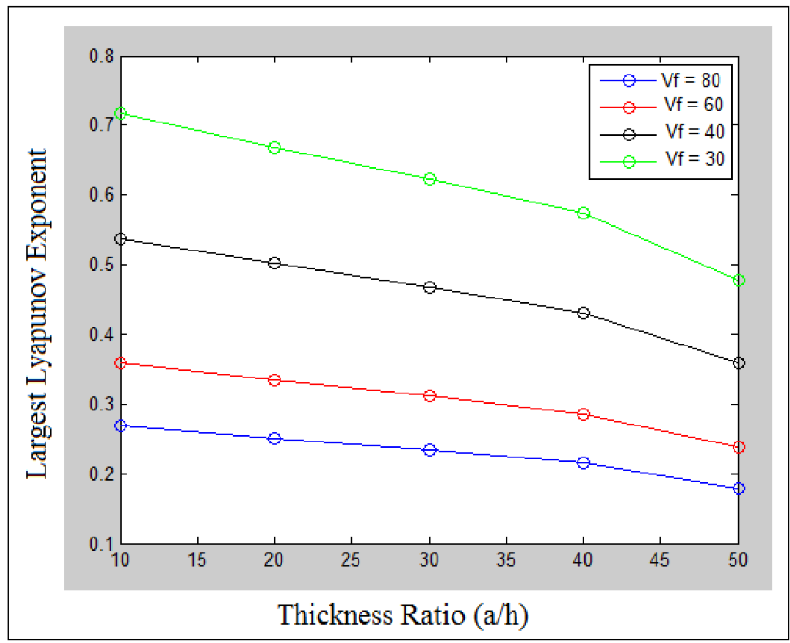
Figure 9. Largest Lyapunov exponent against thickness ratio for un-stiffened plate.